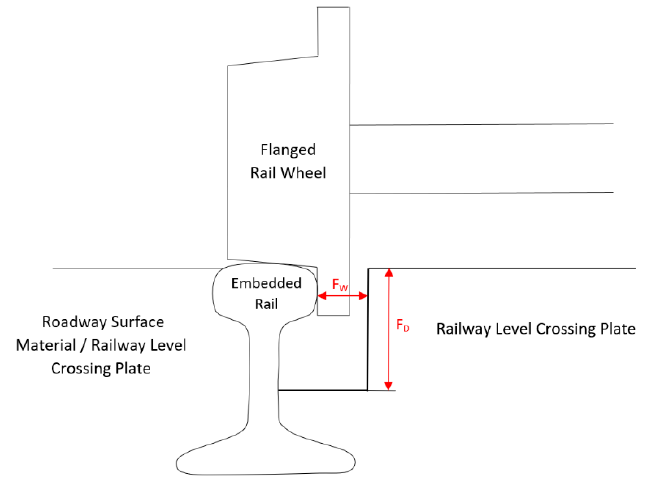
Figure 10. Width ( F W ) and depth ( F D ) of the flangeway of the RLC.